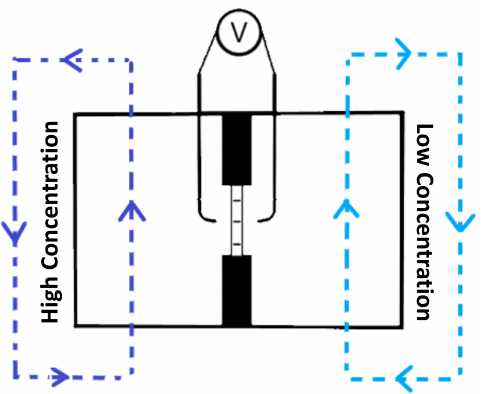
Figure 1. Scheme of two-compartment cell setup for permselectivity